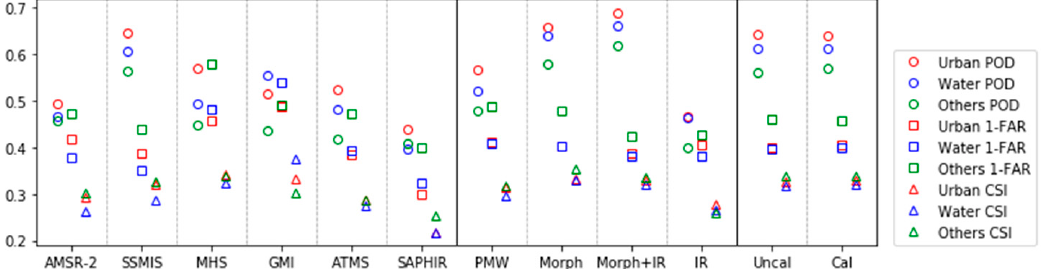
Figure 8. Three categorical indices, POD, FAR, and CSI, for 12 IMERG estimates in urban, water, and other areas.